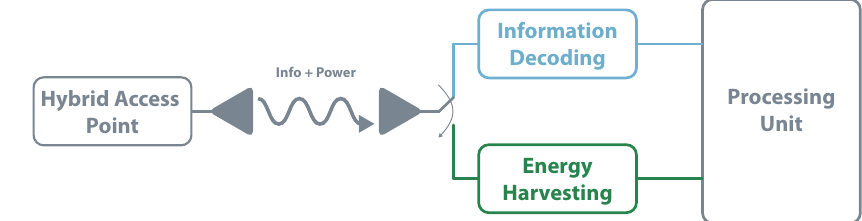
Figure 14. SWIPT—time switching architecture.